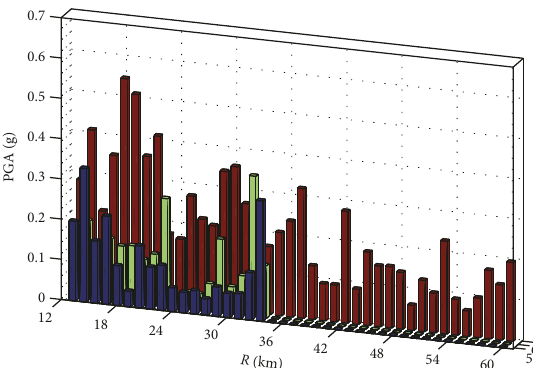
Figure 7: Distribution of far-field ground motions.